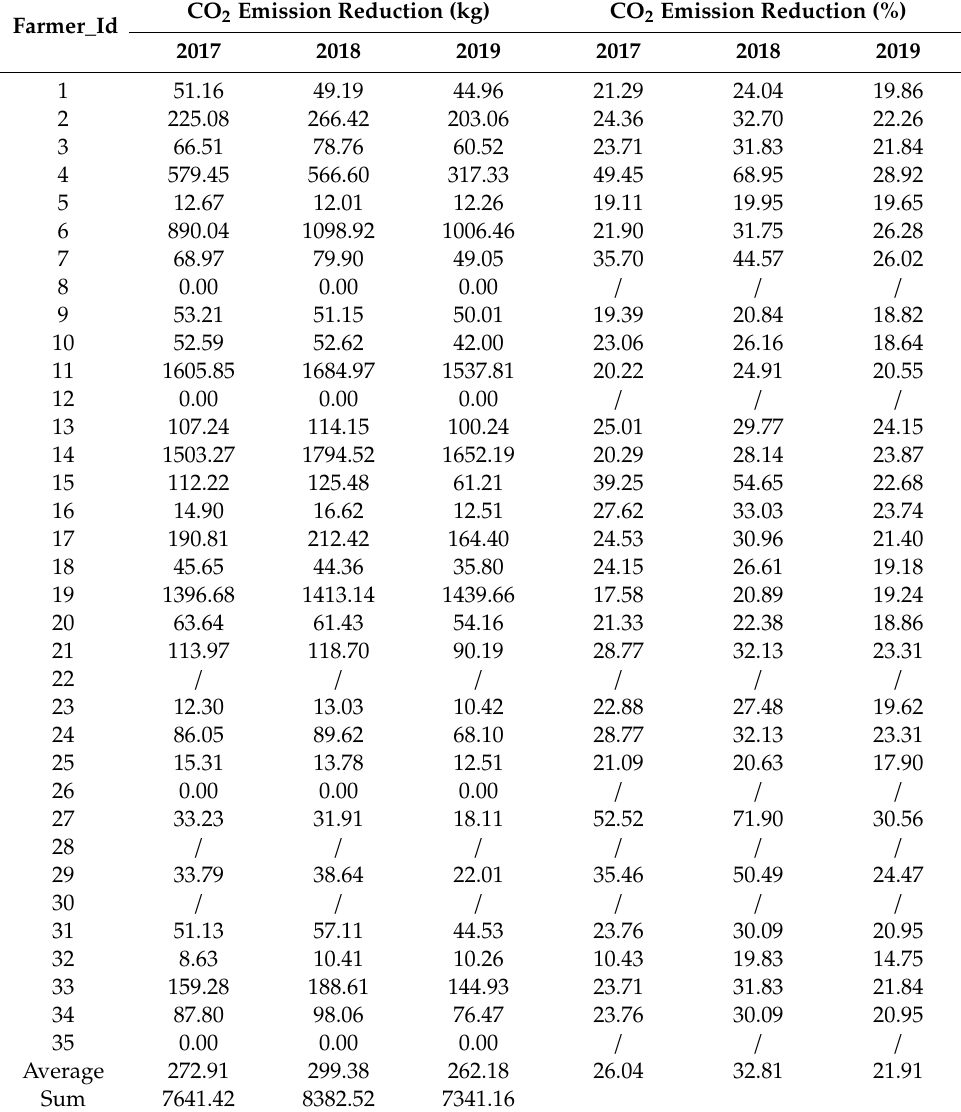
Table A12. Yearly absolute (kg) and relative (%) CO 2 emission reduction at farm level if replenishing soil water content to 85% capacity (FC-WP) instead to